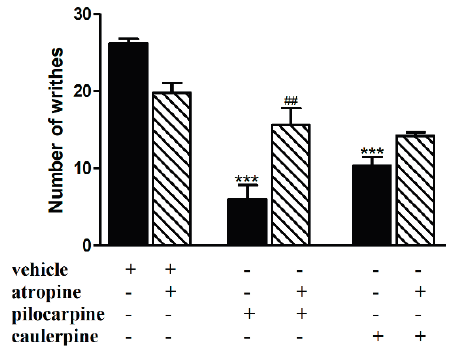
Figure 2. Effect of atropine on the antinociceptive effect of caulerpine in the acetic acid model of nociception. Black columns: treatments alone; hatched columns: pretreatment and treatments. The results are expressed as means ± S.E.M. of six animals. (One-way ANOVA followed by Bonferroni’s test). *** p < 0.001 compared to vehicle; ## p < 0.01 compared to pilocarpine.